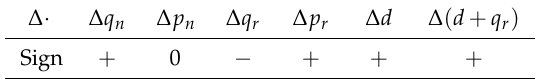
Table 4. Comparison of OEM’s Equilibrium Solutions Between Policys D and